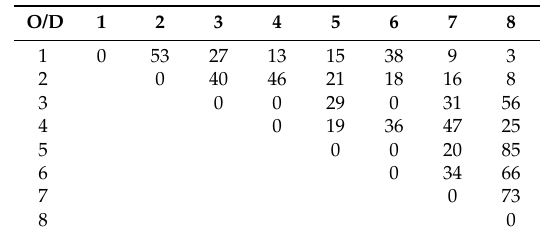
Table A3. Origin–destination